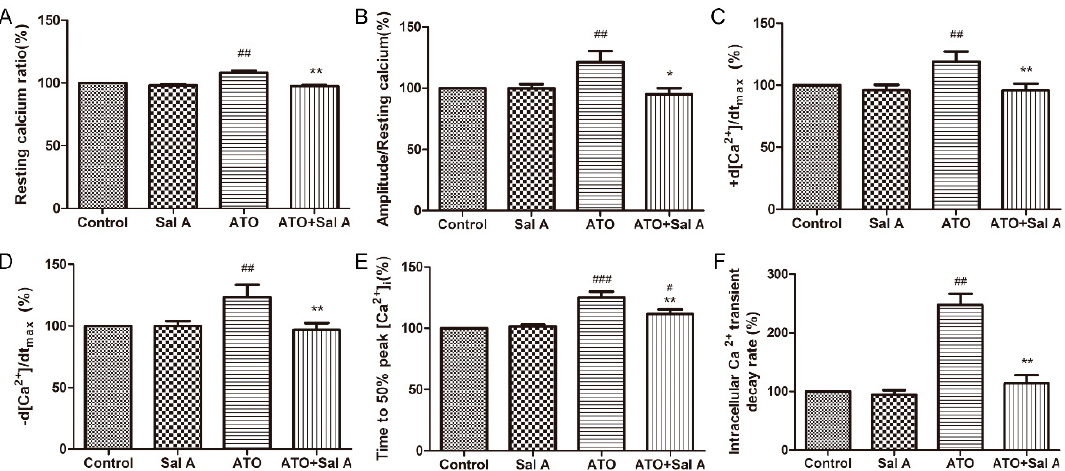
Figure 5. Sal A regulated intracellular Ca 2+ transients in ARVMs after ATO treatment. ( A ) Resting Ca 2+ ratio. ( B ) Amplitude/resting calcium ratio. ( C ) Maximal Ca 2+ shortening velocity (+d[Ca 2+ ]/dtmax). ( D ) Maximal Ca 2+ relaxation velocity ( − d[Ca 2+ ]/dtmax). ( E ) Time to 50% peak [Ca 2+ ] i . ( F ) Intracellular Ca 2+ transient decay rate. Data are expressed as the mean ± SD ( n = 30–40 per group), # p < 0.05 vs. control, ## p < 0.01 vs. control, * p < 0.05 vs. ATO, ** p < 0.01 vs. ATO.